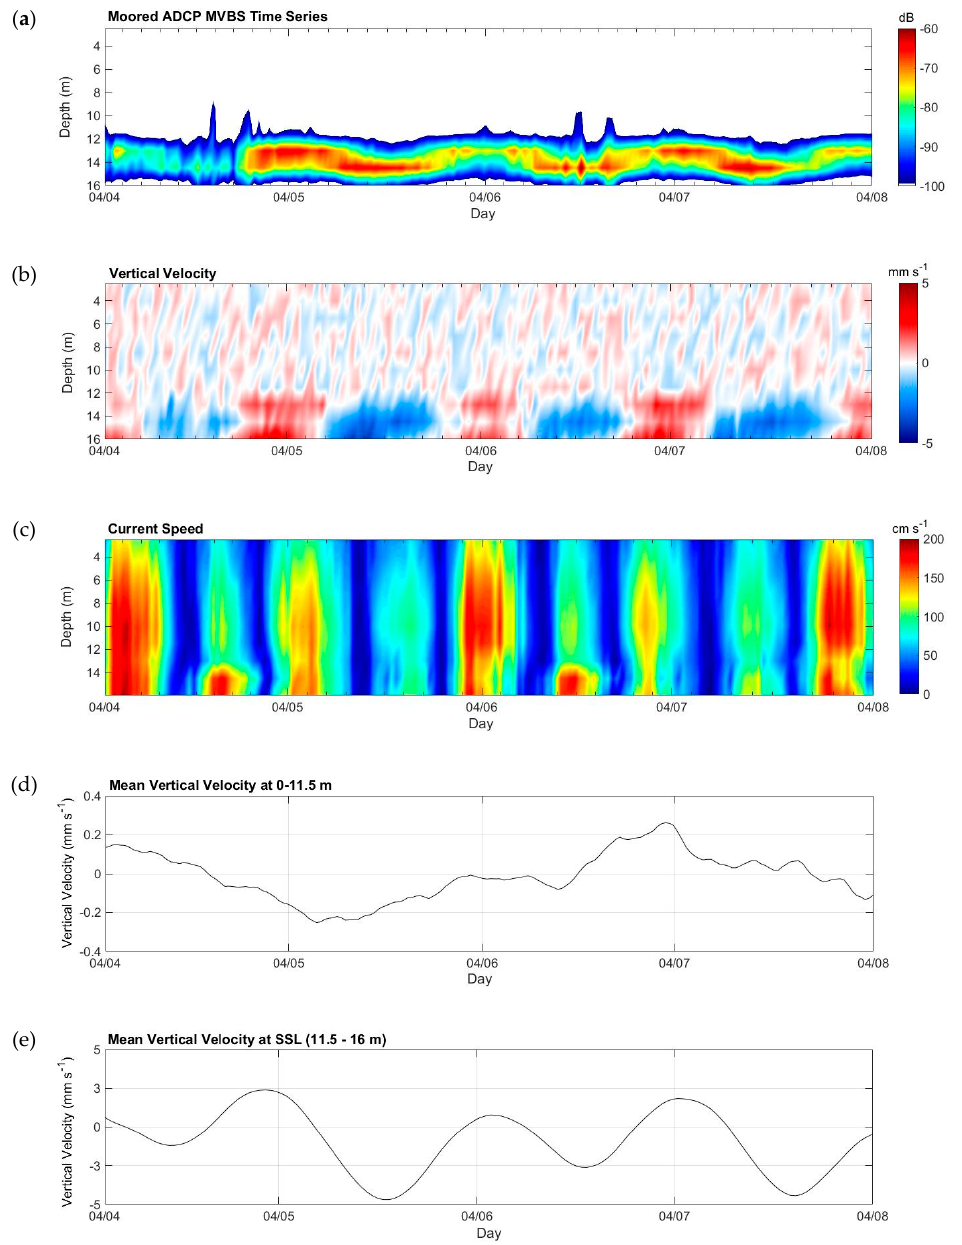
Figure 9. Observed zooplankton’s DVM pattern from the comparison of ( a ) MVBS values with ( b ) vertical velocities and ( c ) current speed obtained from mooring ADCP. The graph line was mean vertical velocity in ( d ) surface to 11.5 m of depth and (e) in the sound scattering layer (11.5–16 m). The maximum average velocity speed of upward vertical movement was 5 mm s -1 at the center of the SSL. It started moving downward slowly at sunrise and reached the peak at -5 mm s -1 . This slow movement of zooplankton in the observed area was due to their small size. Mean vertical velocity at sunset was slower than at sunrise. The dashed line inside the echogram in Figure 10